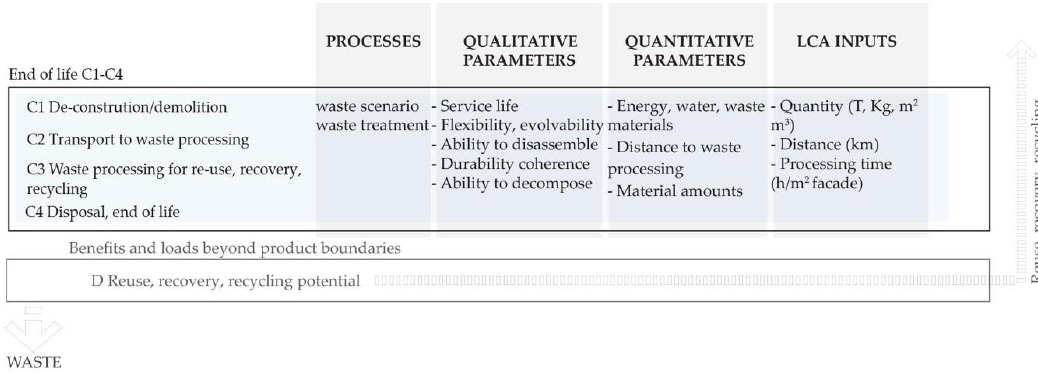
Figure 10. Mapping of LCA parameters in the phase C1-C4.